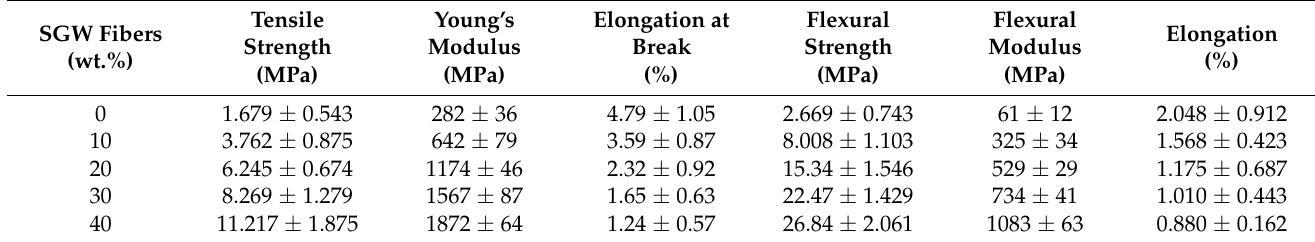
Table 7. Mechanical properties of composite materials of TPL/PCL and